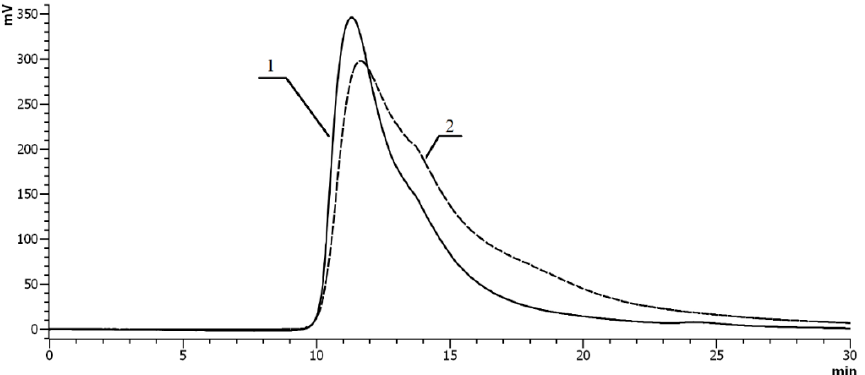
Figure 8. SEC chromatograms of the VP–VDTC (1—solid line), VP–VDTC–In (2—dashed line) copolymers ( M r = 12 × 10 3 Da, 6 mol.% of NH 2 groups). Ultrahydrogel linear column (7.8 × 300 mm) with a pre-column (0.6 × 40 mm). Eluent: aqueous solution of 0.2 M NaCl, λ = 210 nm.